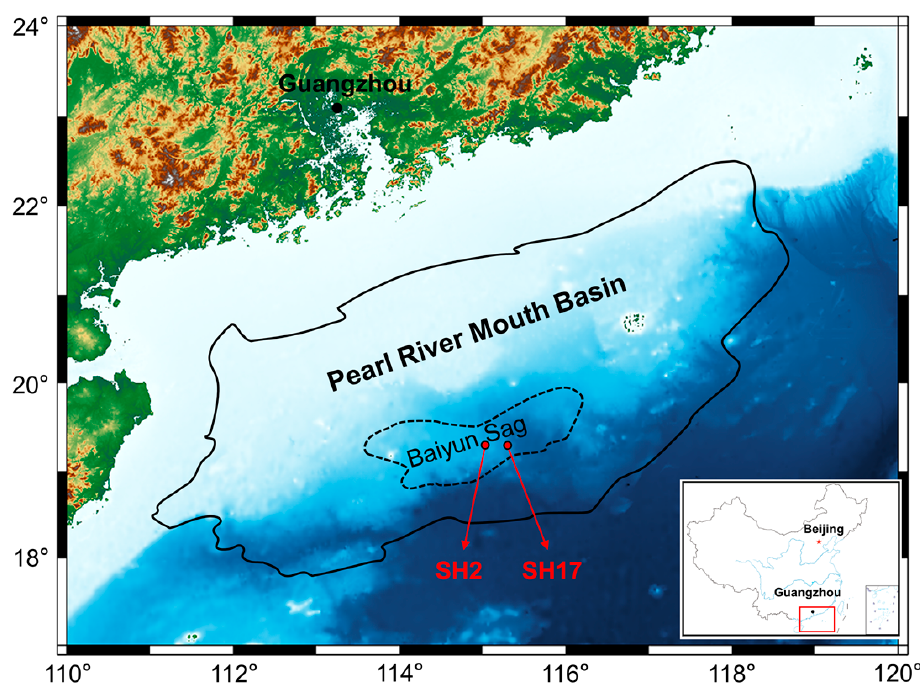
Figure 7. Regional geological map of the study area. The locations of SH2 and SH17 wells are indi-